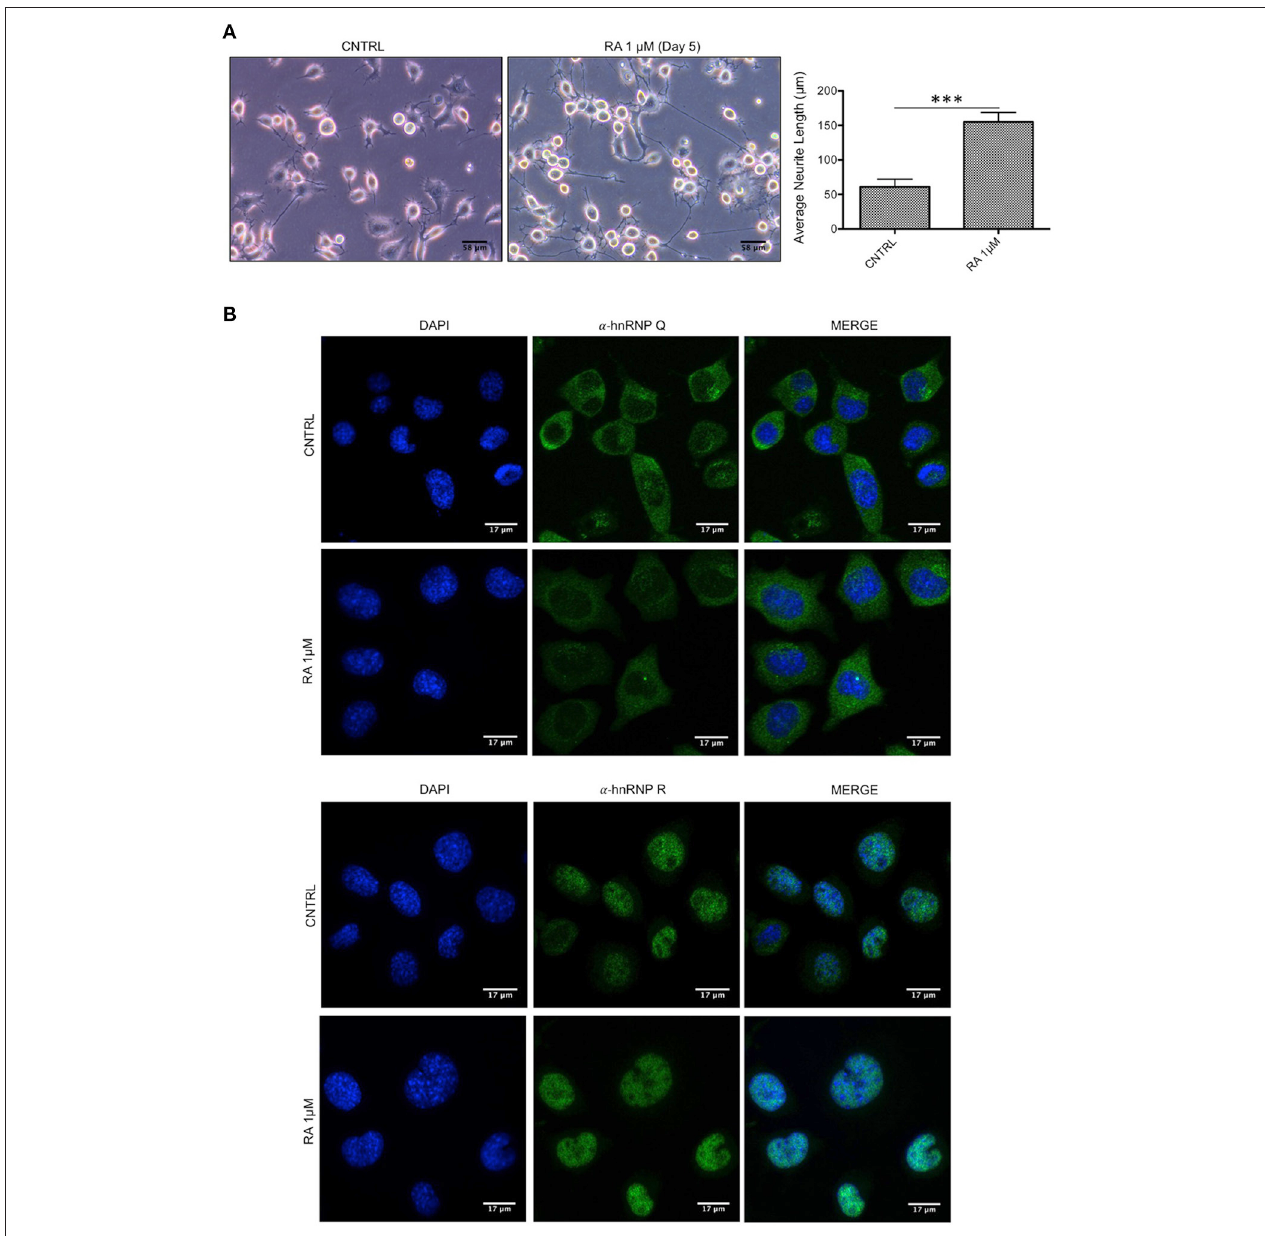
FIGURE 2 | Endogenous localization of hnRNP Q and hnRNP R is not affected by differentiation in NSC-34 cells. (A) Light microscopy images of undifferentiated (CNTRL) and differentiated cells treated up to 5 days with medium containing 1 µ M of all-trans retinoic acid (RA 1 µ M). Scale bars: 58 µ m, 20X magnification. Neurite length comparison (gray bars) of CNTRL and RA is also reported as mean ± standard error. Statistical differences were evaluated using t-students (*** p < 0.001). (B) Immunofluorescence analysis of the endogenous mouse hnRNP Q and hnRNP R (shown in green) in NSC-34 cells with or without 1 µ M RA treatment. Nuclei were visualized using DAPI staining. Scale bars: 17 µ